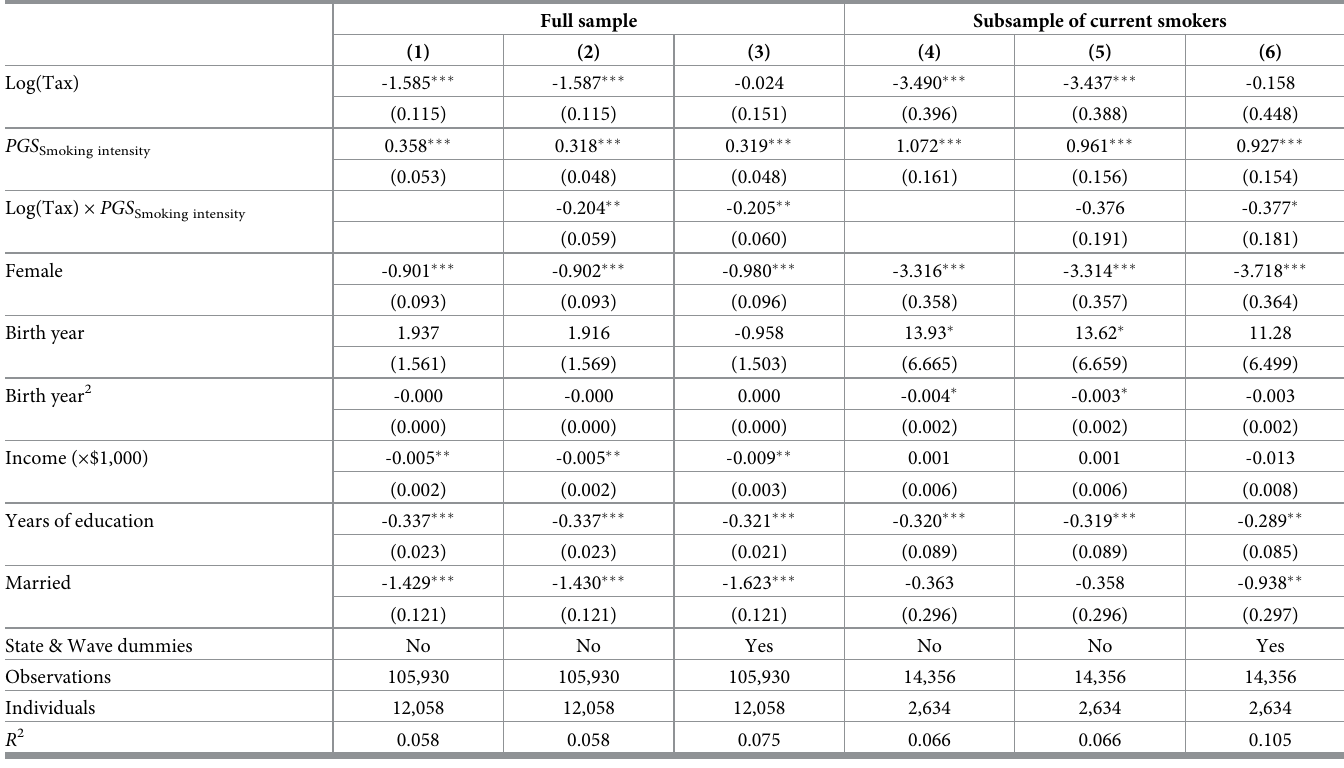
Table 3. Results of the regressions explaining an individual’s smoking